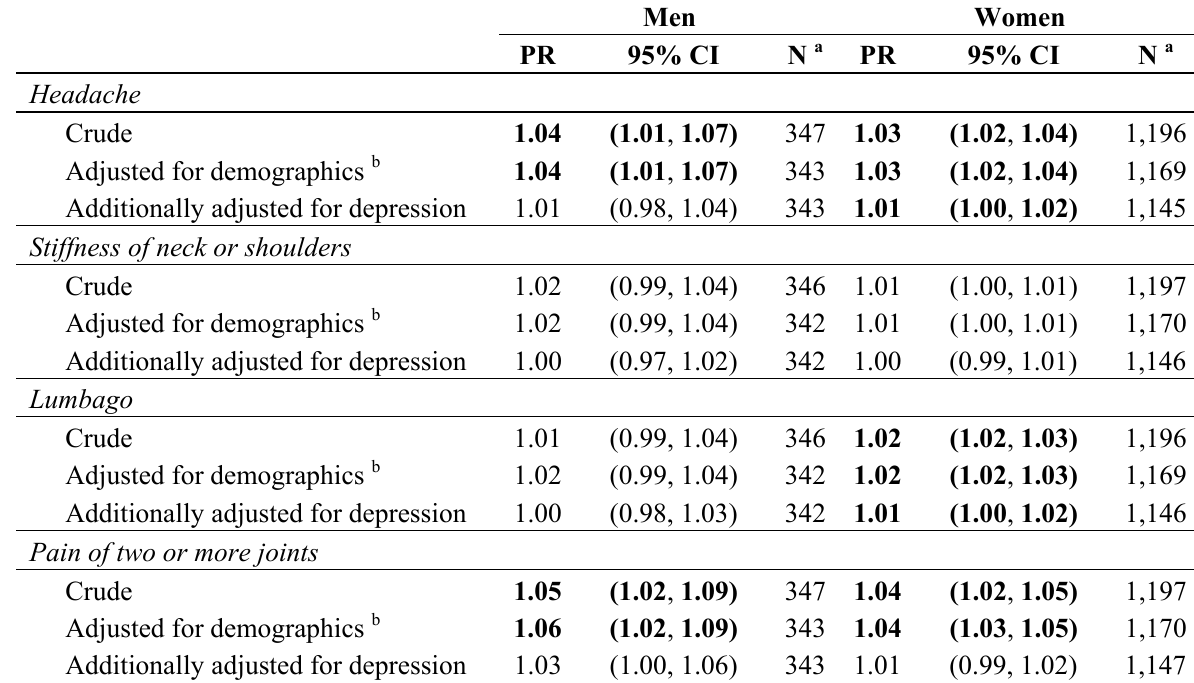
Table 2. Changes in the prevalence ratio associated with a 1-point increase in the person-related bullying score.